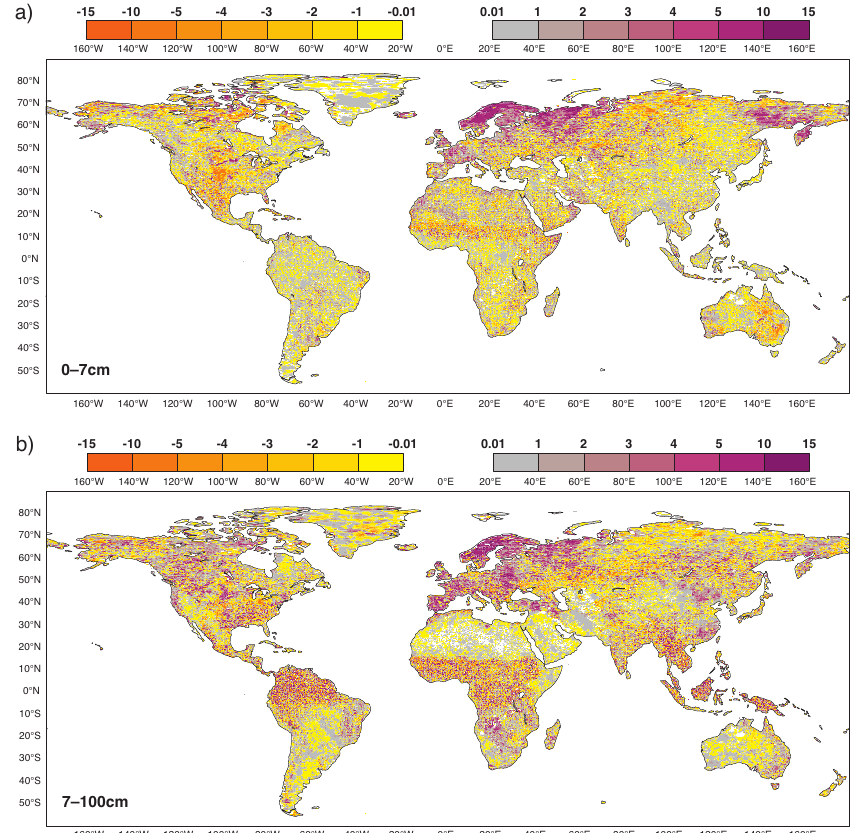
Figure 9. Accumulated soil moisture increment differences between EXPT (assimilation of screen-level variables and SMOS T ) and CTRL (assimilation of only screen-level variables) B from 1 to 15 July 2012. Panel ( a ) is for the top layer and panel ( b ) for the deep layer. Soil moisture differences are integrated over the depth of the layer and shown in mm